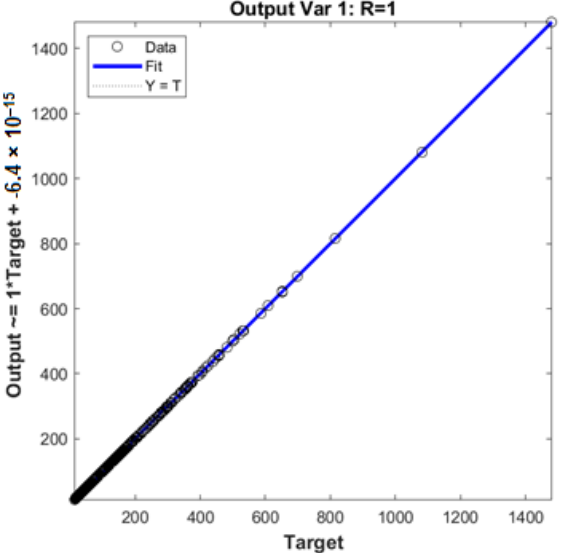
Figure 5. Comparison between predicted shear capacity and calculated shear capacity.